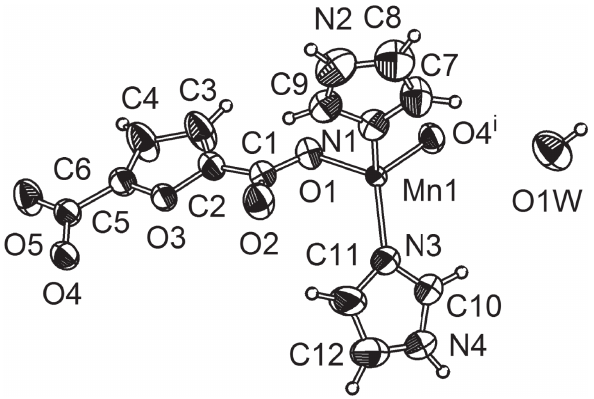
Table 2: Fractional atomic coordinates and isotropic or equivalent isotropic displacement parameters (Å 2